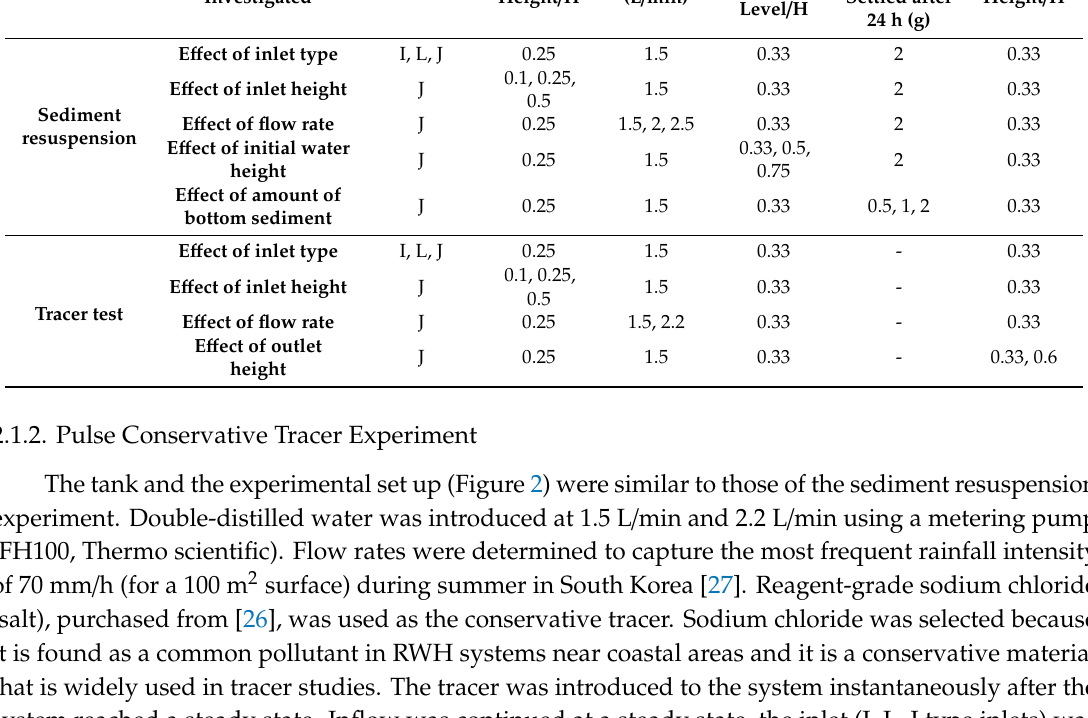
Figure 2. Inlet types considered (a, I type; b, L type; c, J type) in the particle and tracer experiments ( left ) and experimental set up ( right ). NaCl was added for the tracer test and kaolin clay bottom sediment was present only for the particle resuspension experiment. Table 1. Specifications of the sediment resuspension experiments and tracer study experiments.